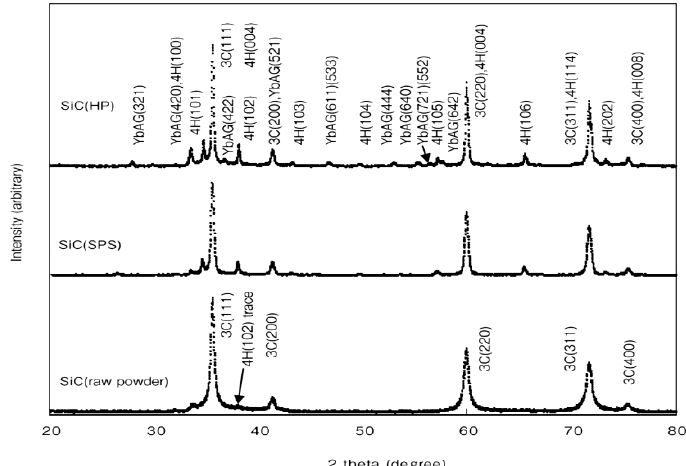
Figure 22. XRD patterns obtained from raw powder, SPS-and HP-SiCs.